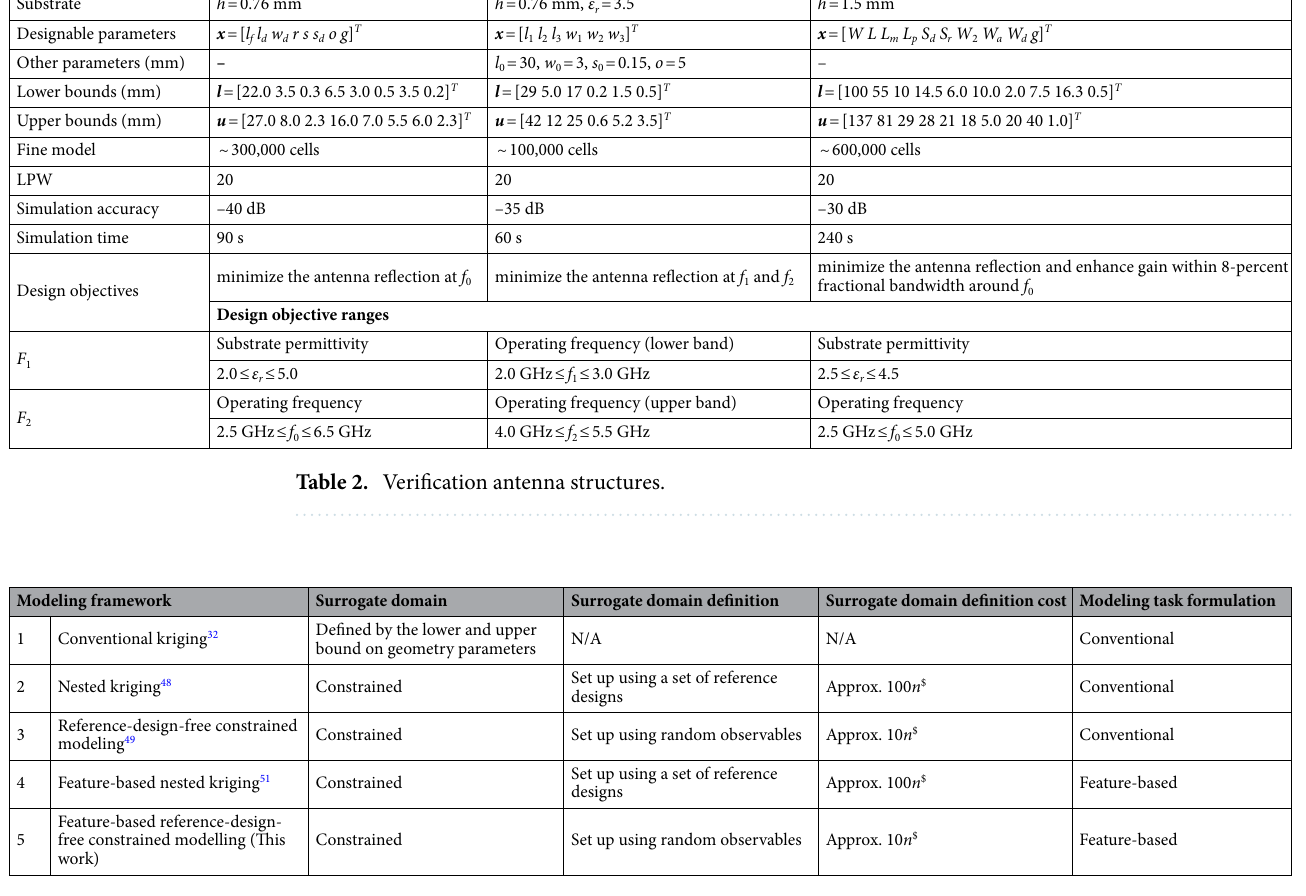
Table 3. Constrained modeling: basic object definitions. $ n denotes the number of the antenna geometry